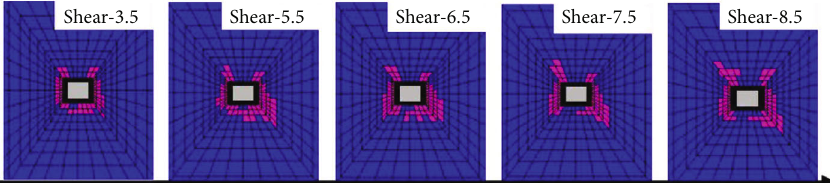
Figure 11: Plastic deformation of the rock mass around the roadway when the shear modulus is di ff